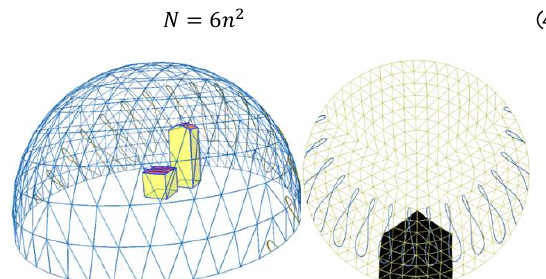
Figure 12 Sky Dome and Sun’s position and visibility of sky patches